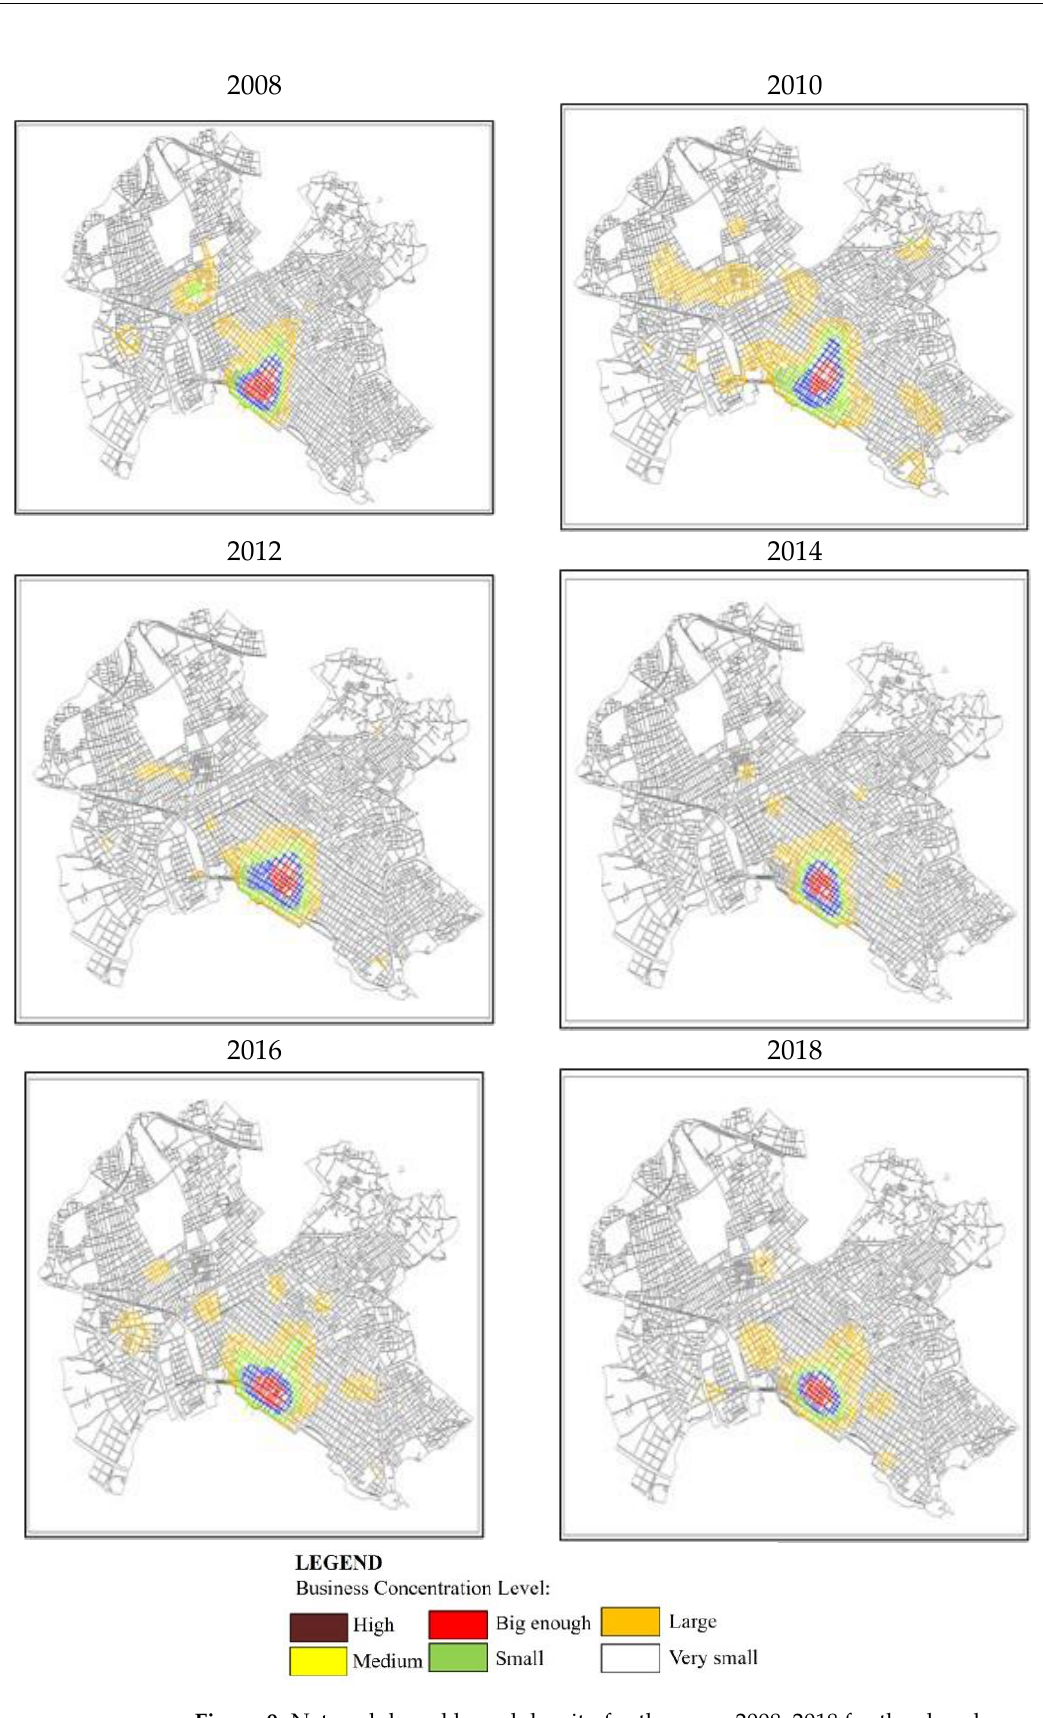
Figure 9. Network-based kernel density for the years 2008 – 2018 for the closed companies, Source: Chamber of Magnesia, Own processing.